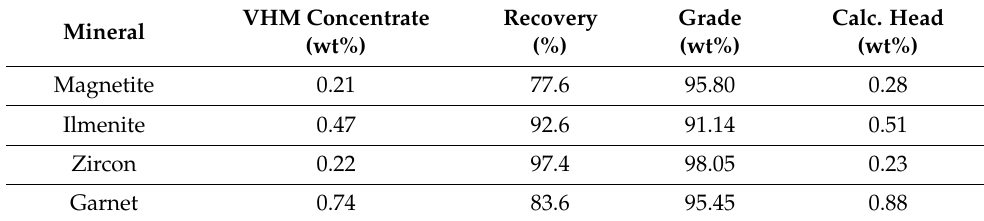
Table 4. Summary of results for the average recovery of VHM into the combined concentrate.